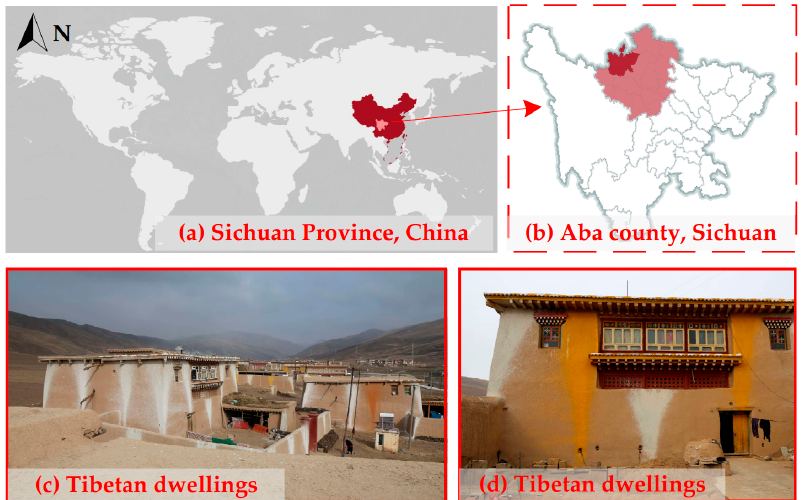
Figure 2. The research location and the architectural style.